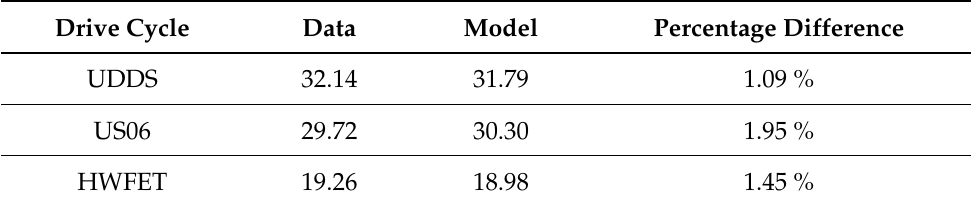
Table 7. EPA dynamometer drive cycle FE (km/L) results from the Autonomie 2010 Toyota Prius model and ANL D 3